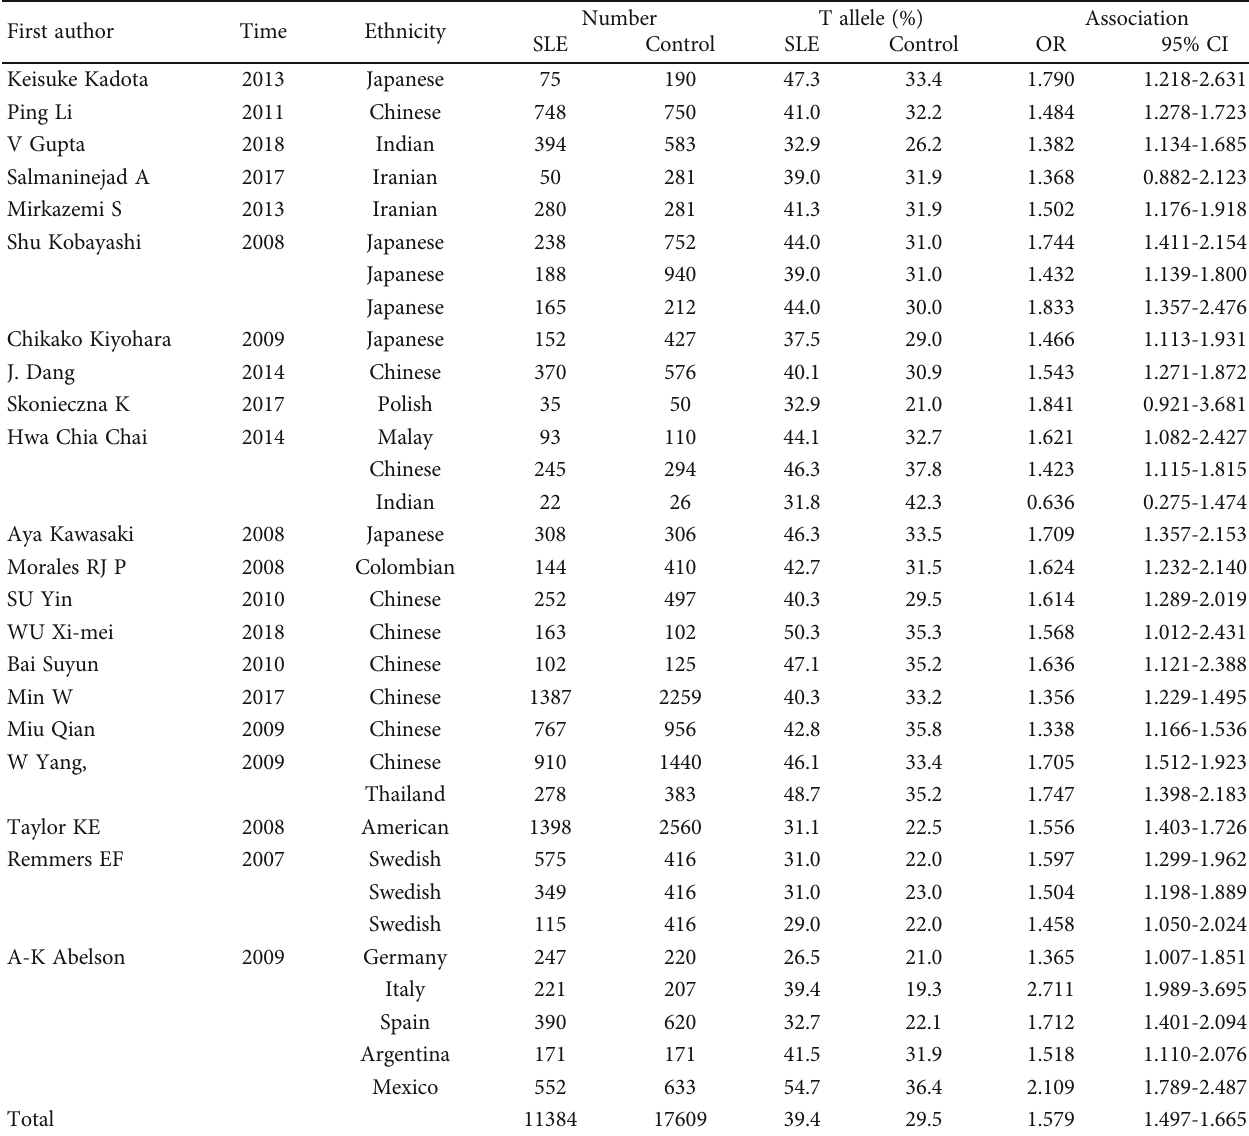
Table 1: Characteristics of individual studies included in